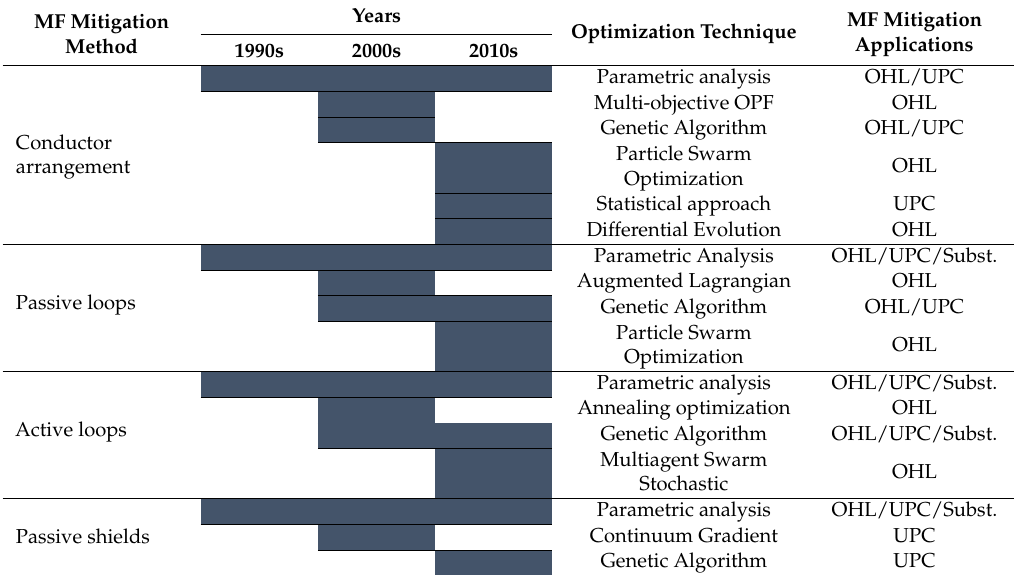
Table 2. A timeline of applications for MF mitigation and related optimization